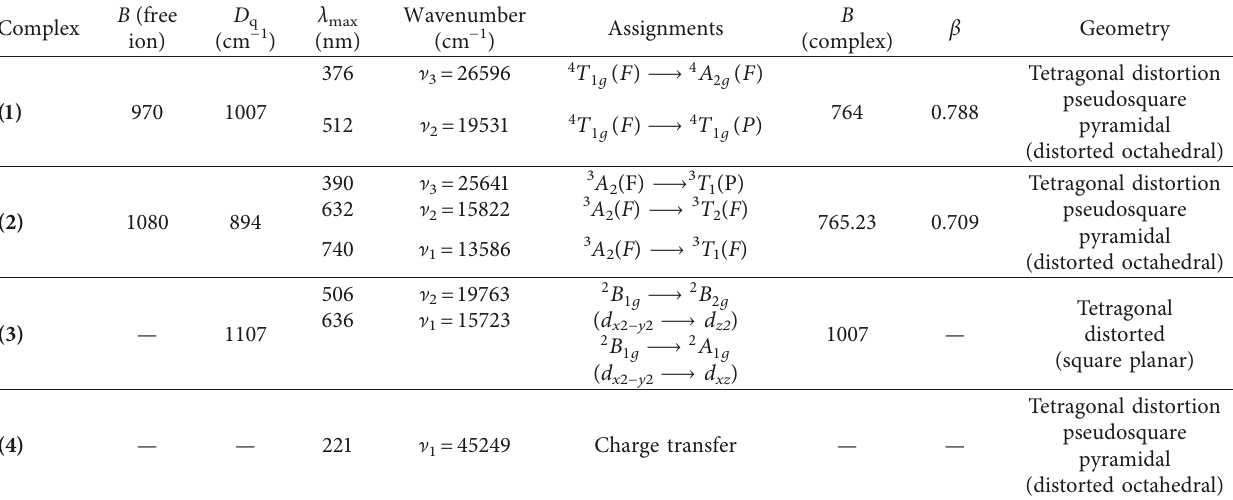
Table 4: Electronic spectral data, λ